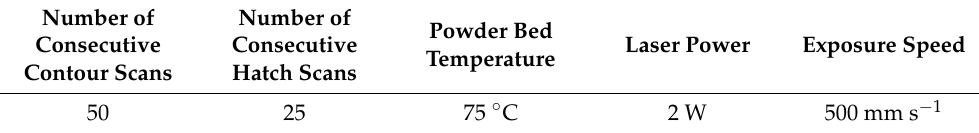
Table 2. Exposure parameters of the fractal, quasi-simultaneous exposure of thin-walled components.